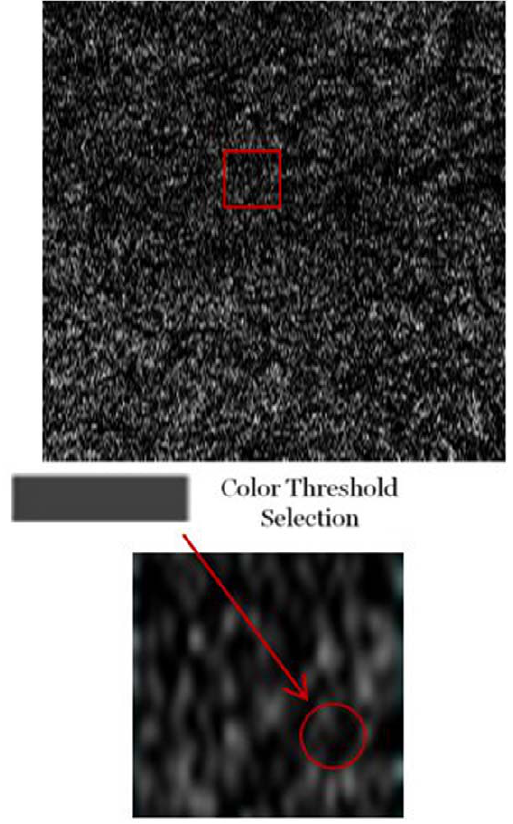
Figure 3. Selecting Pixel Intensity Threshold for Choroidal Vessel Density Analysis. Choroidal C-scans (top image) were obtained using the advanced visualization feature of macular cubes consisting of 512 6 128 optical coherence tomography volume scans over a 6 mm square grid. Each C-scan was a 2 micron-thick scan from each of the three choroidal layers. A customized image analysis program was used for both full C-scans (top image) and a selected region of each scan (inset) for all patients. A strict threshold of R=65, G=65, and B=65 pixel intensity combination was selected for vessel versus stroma